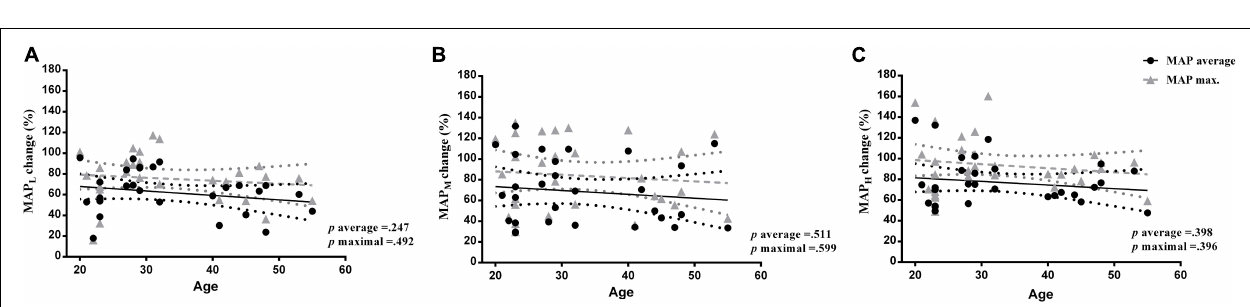
FIGURE 2 | Percent change in the mean arterial pressure (MAP%) during the flywheel exercise for both the average and maximal readings. # – significant load effect – different from low-level iso-inertial load.